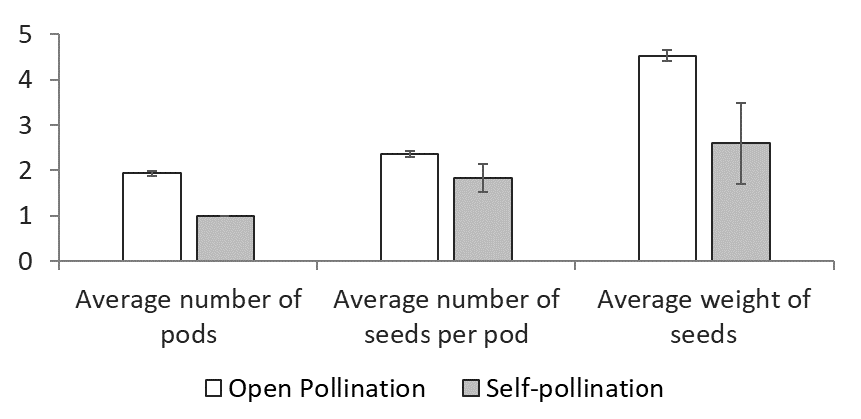
Fig. 5. The average number (± standard error; right), seed numbers (± standard error; middle), and weight (gr; ± standard error; left) of pods produced per inflorescence of V. faba in open pollination and self-pollination